Question: From the figure, is the trend upward or downward?
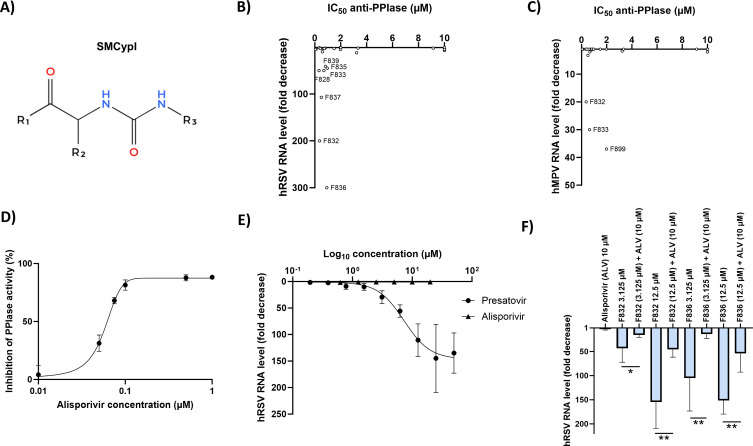
Answer: increasing